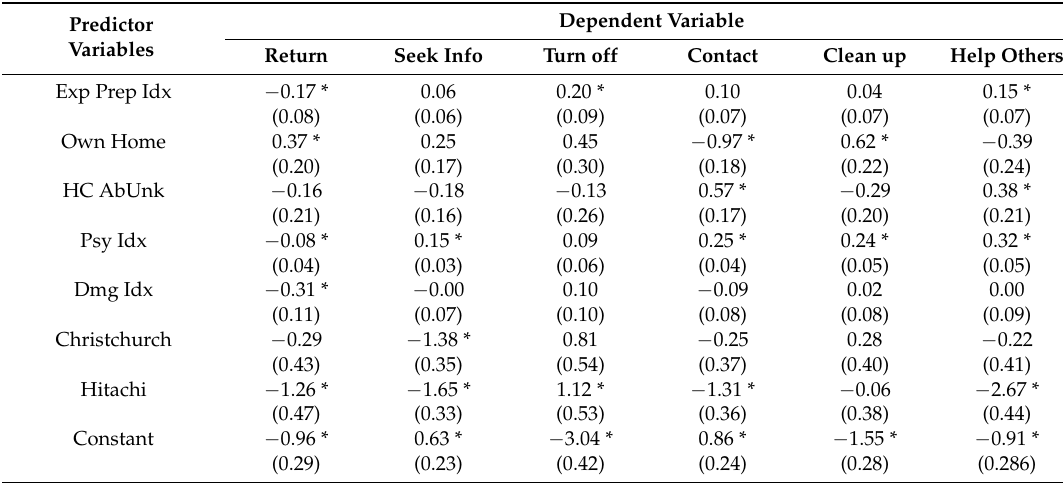
Table 3. Regression